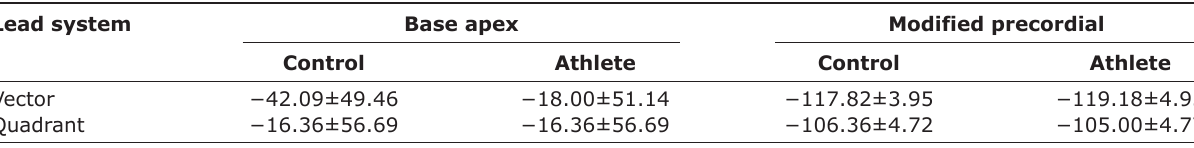
Quadrant Data represented as mean±SEM Table-5: Echocardiographic parameters. Parameters